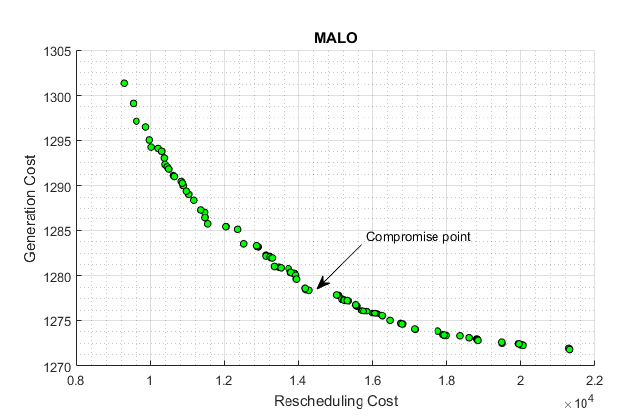
Figure 9. Generation and Rescheduling Cost Convergence curve by MOALO (Case